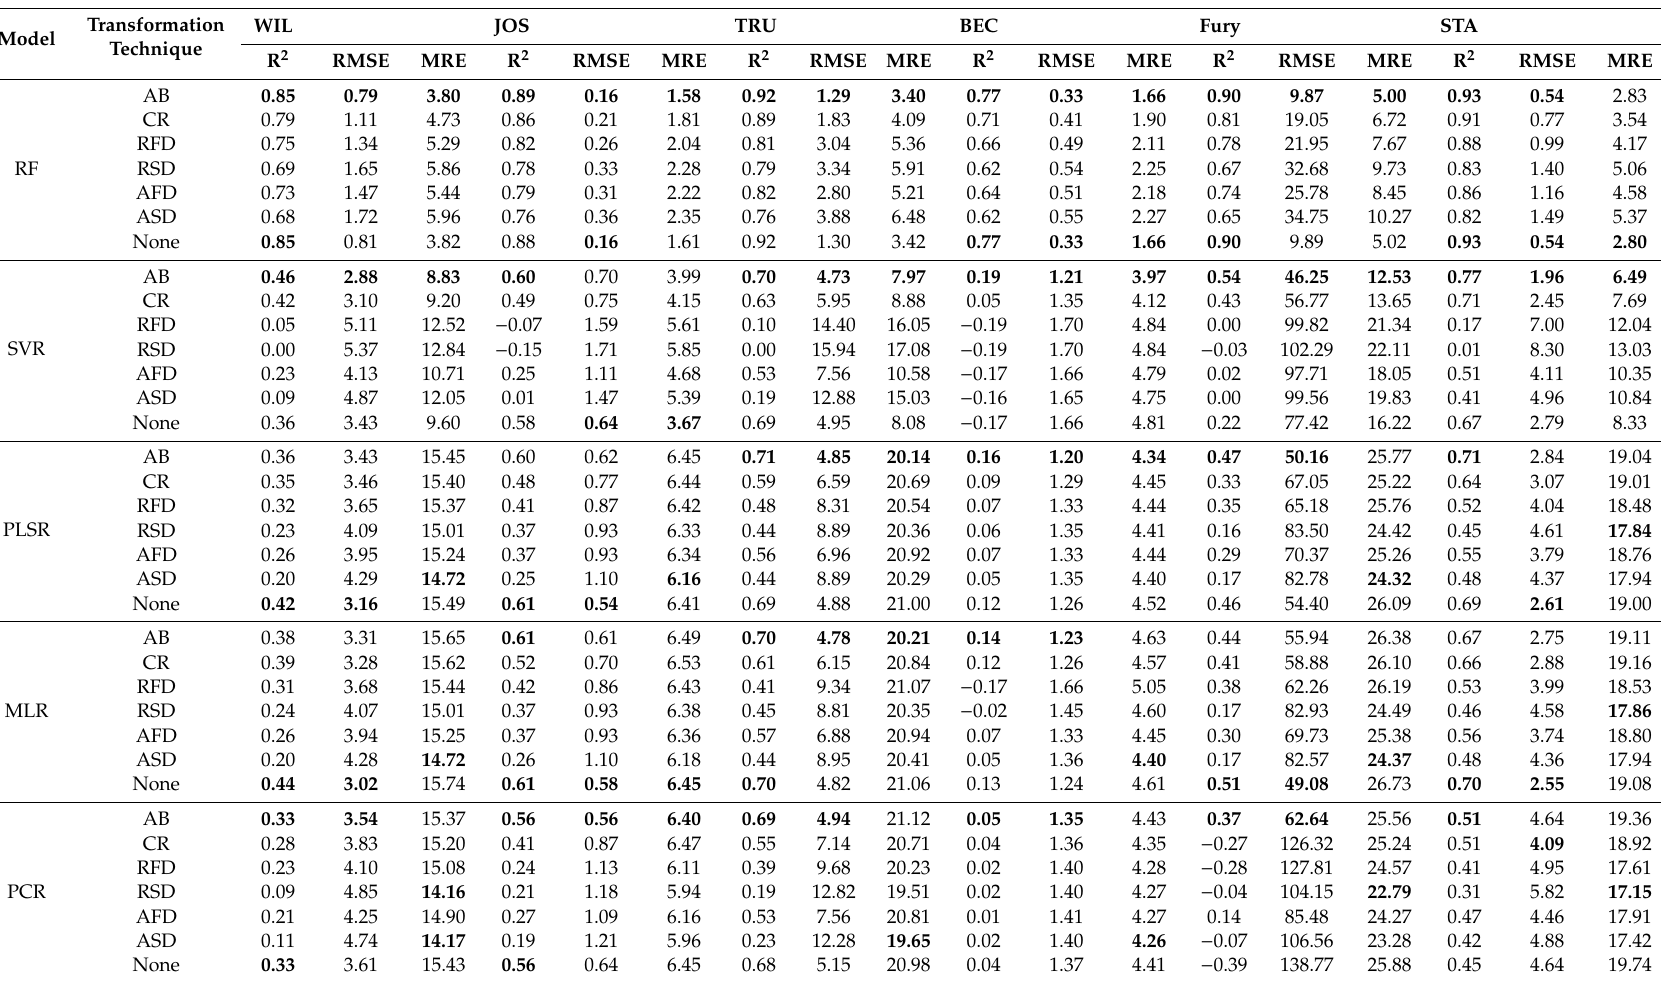
Table 3. Comparative results for the di ff erent regression models and transformation techniques. Data are from the total set (calibration and validation). Values in bold indicate the best results for each model.